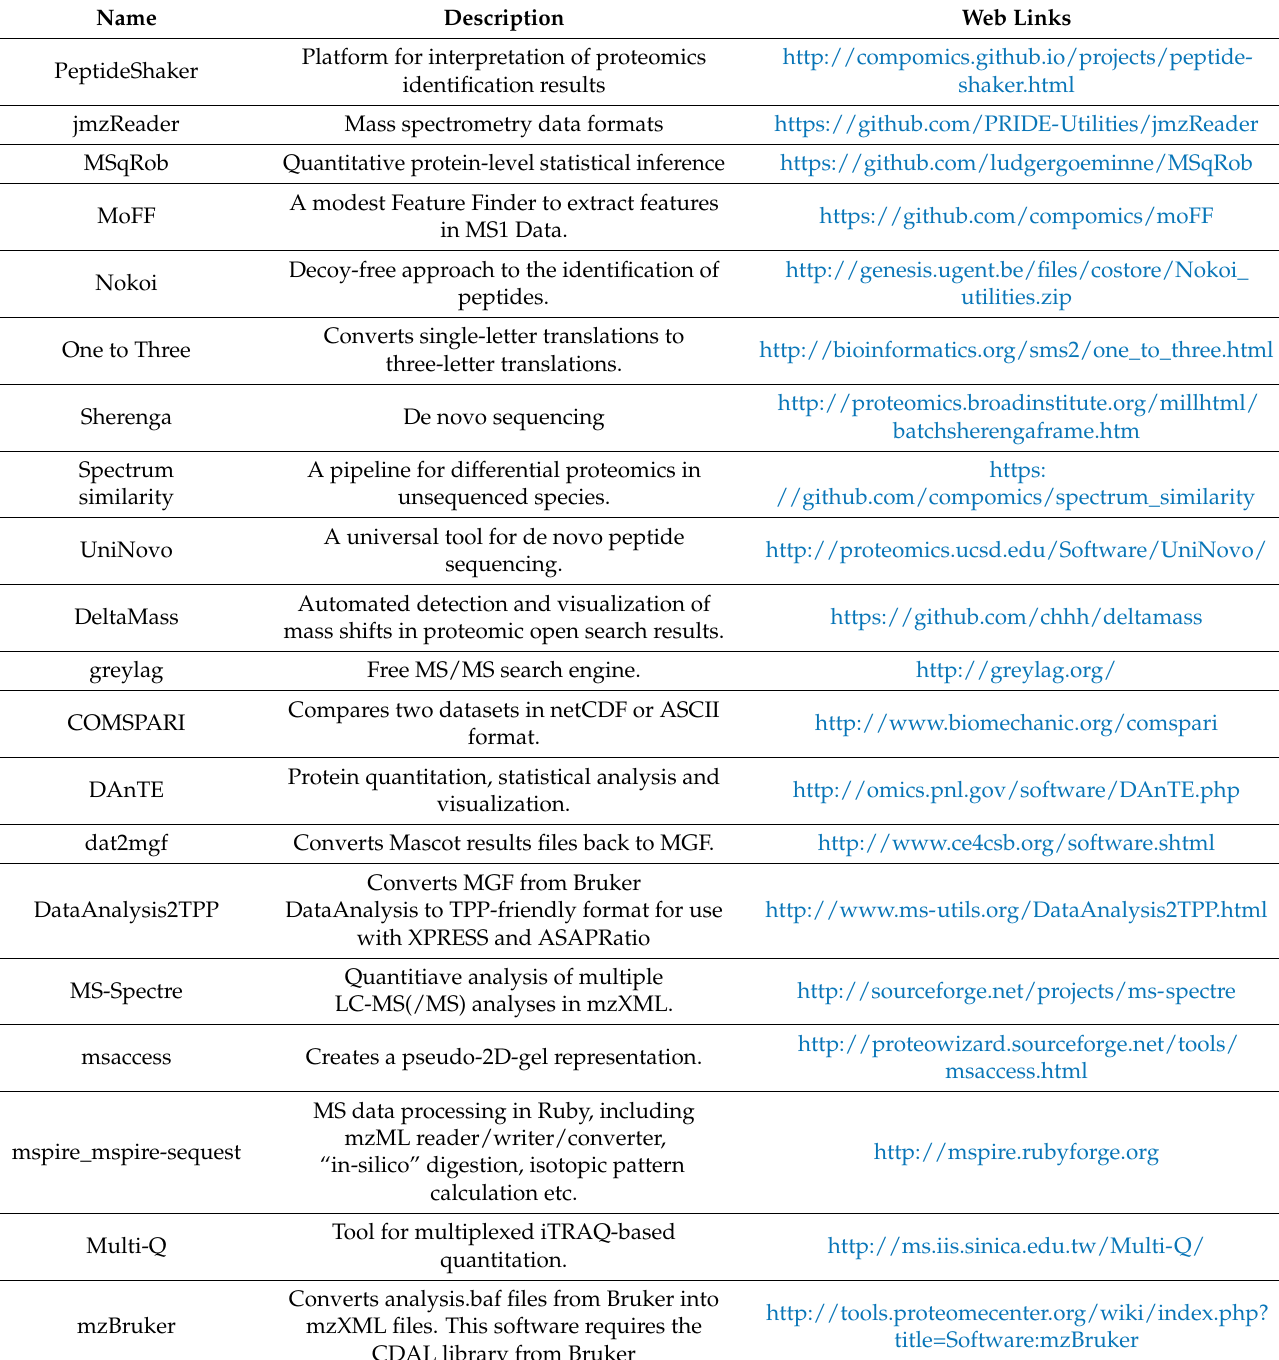
Table 1. General Protein Sequence Databases, 2-DE tools, Sequence Similarity Search, Alignment Tools and Structural Analysis and Prediction